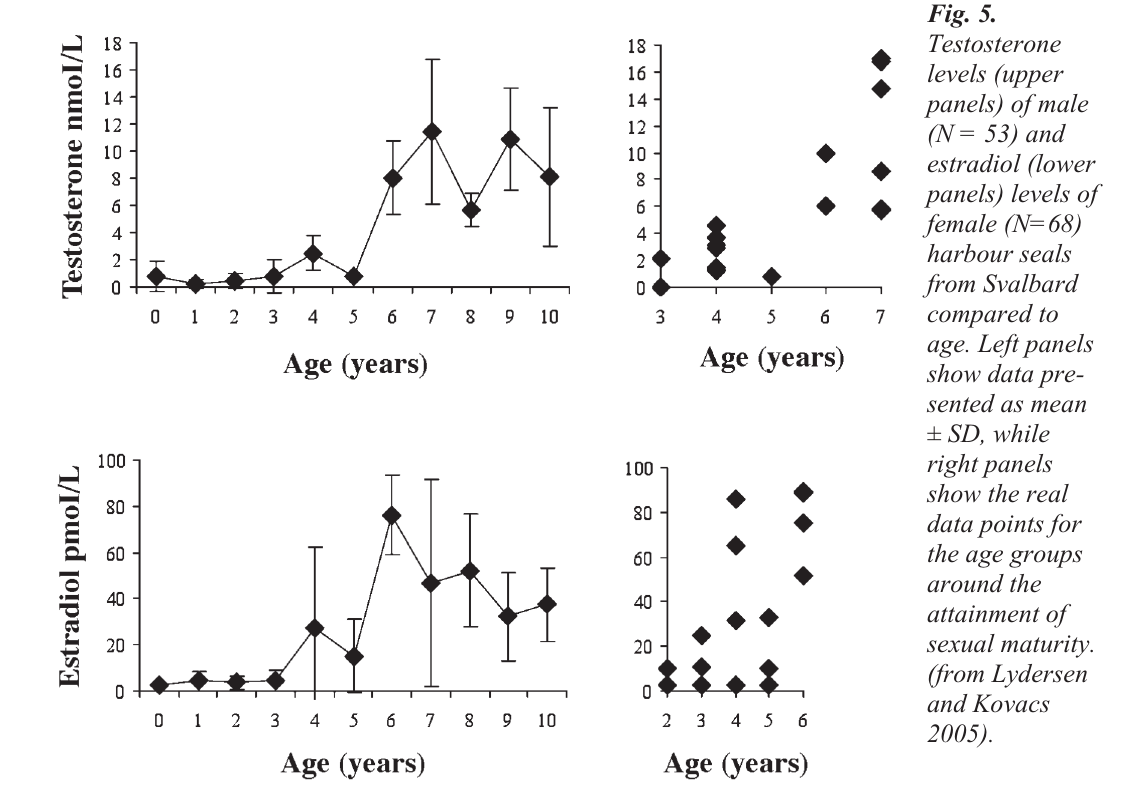
Fig. 5. Testosterone levels (upper panels) of male (N = 53) and estradiol (lower panels) levels of female (N=68) harbour seals from Svalbard age. Left panels